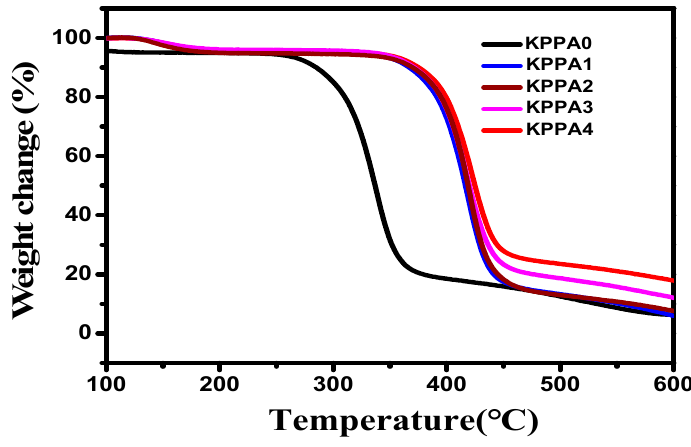
Figure 6. TGA curves of the KPPA0, KPPA1, KPPA2, KPPA3 and KPPA4 cryogels.